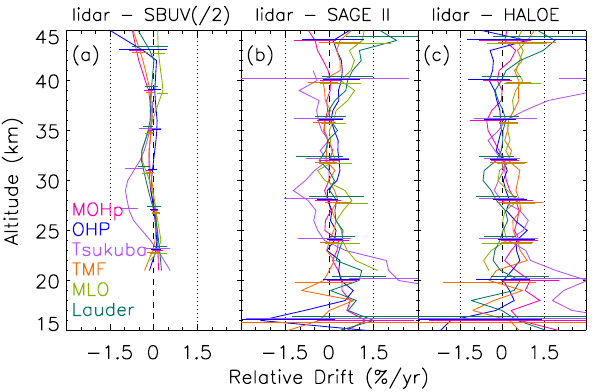
Fig. 5. The drifts of various lidars for the comparison with (a) SBUV(/2), (b) SAGE II and (c) HALOE as references (cid:16) (cid:17) 100 × lidar − ref . The error bars correspond to the 95% confidence ref interval of the